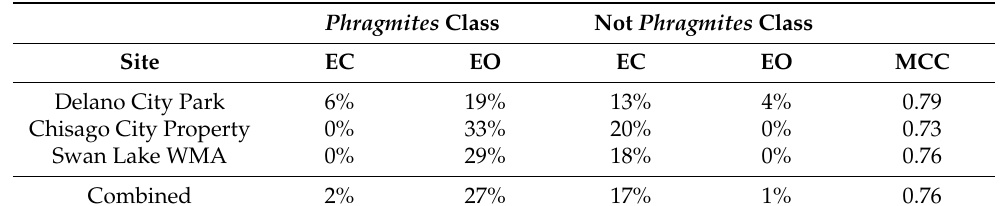
Table 11. Errors of commission (EC), errors of omission (EO), and Matthews correlation coefficient (MCC) values for the artificial neural network classification without the post-ML OBIA rule set.